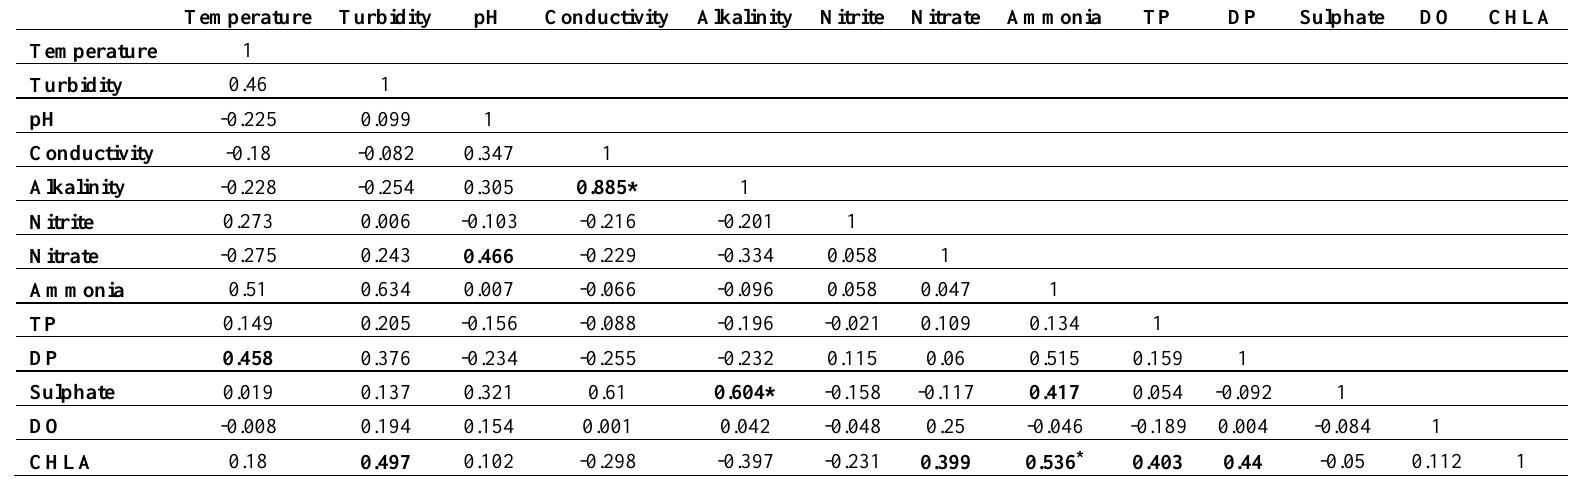
Table 3: Pearson correlation matrix on transformed environmental variables with Bonferroni adjusted probabilities for 13 measured environmental variables during the wet season in the 38 reservoirs. * Indicates significant correlation at p <